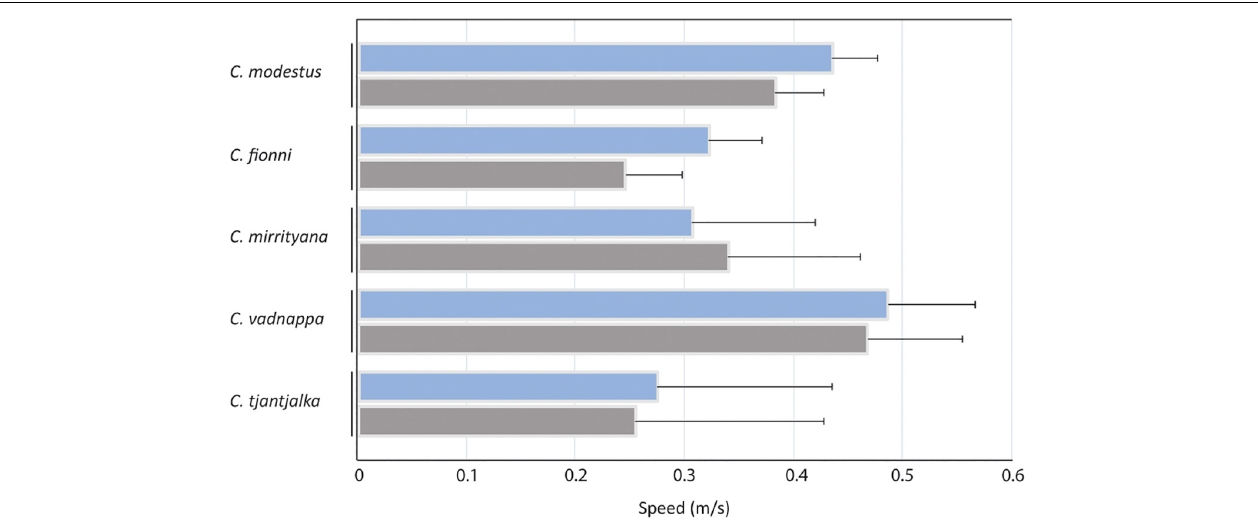
FIGURE 5 | Comparisons of the motion speeds used by all species when all motor patterns are averaged (blue), and individually for head bobs (gray). Estimated marginal means, calculated from the linear model, are presented for C. modestus , C. fionni , C. mirrityana , C. vadnappa and C. tjantjalka . Error bars represent 95% confidence